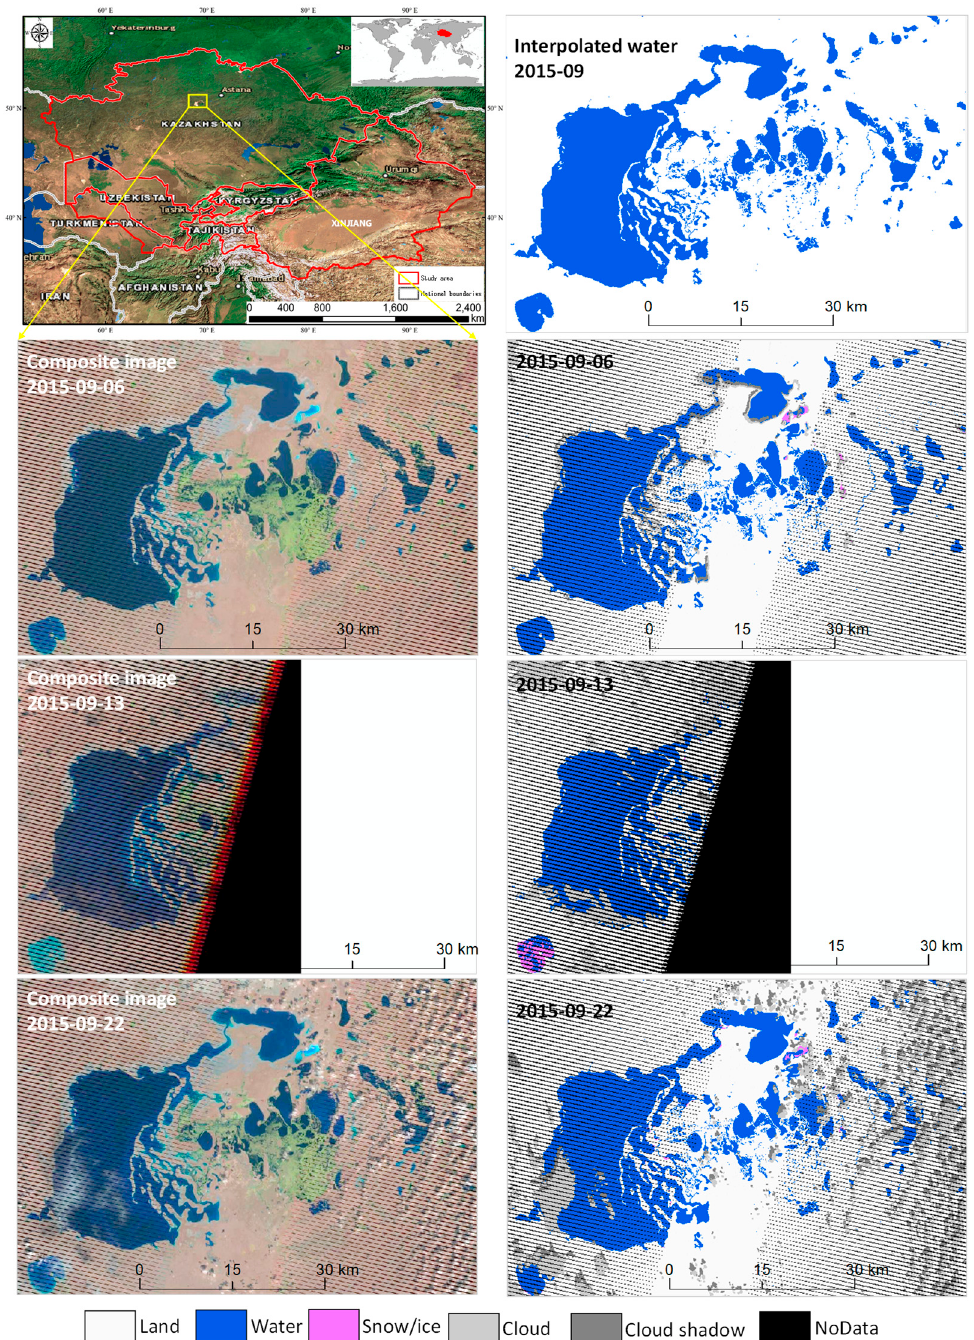
Figure 6. The water map directly derived from the available Landsat images and interpolated water map. The zoomed-in areas are from Tengiz-Korgalzhyn Lake in the north of Kazakhstan.